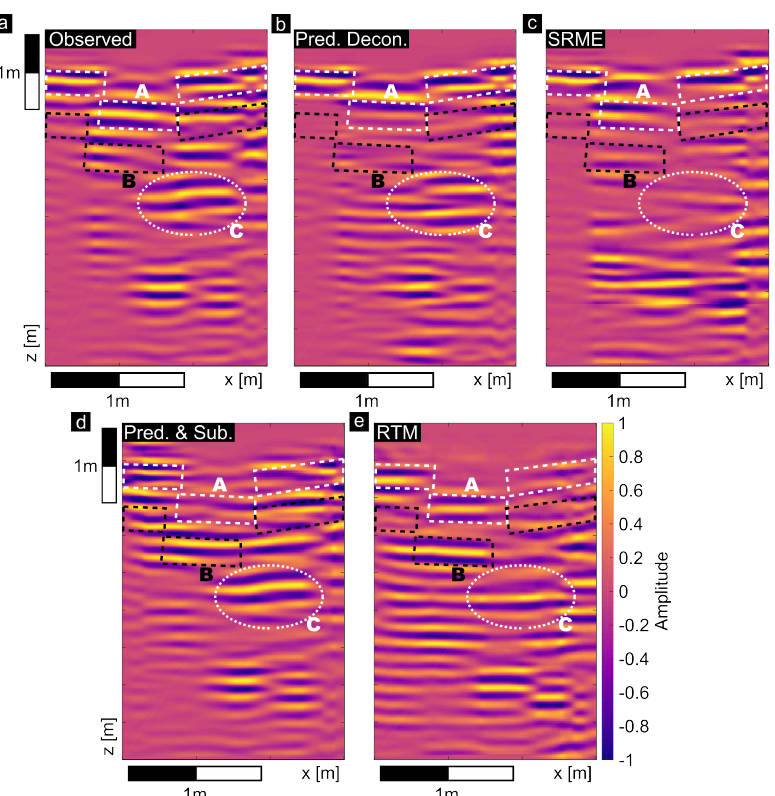
Figure 9. Multi-offset section of field data set 1 from Puck, Poland. The original data ( a ) and results of all four multiple attenuation approaches are shown ( b – e ). The water bottom reflection (A) and the first water-layer multiple (B) are highlighted. C shows a reflection that is enhanced by methods A and B.